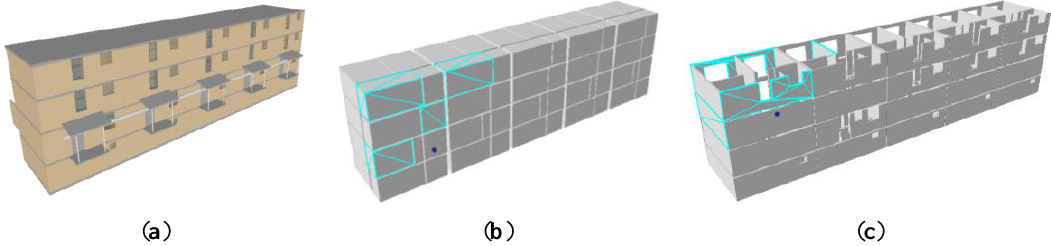
Figure 6. ( a ) IFC building. ( b ) Spaces in IFCSpace feature class. ( c ) Walls in IFCWallStandardCase feature class.